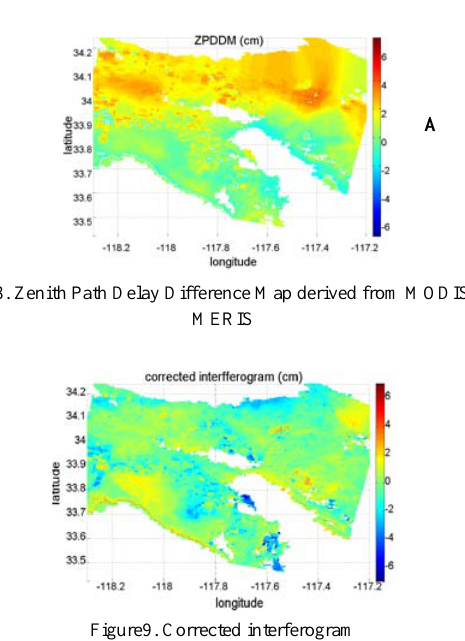
Figure9. Corrected interferogram